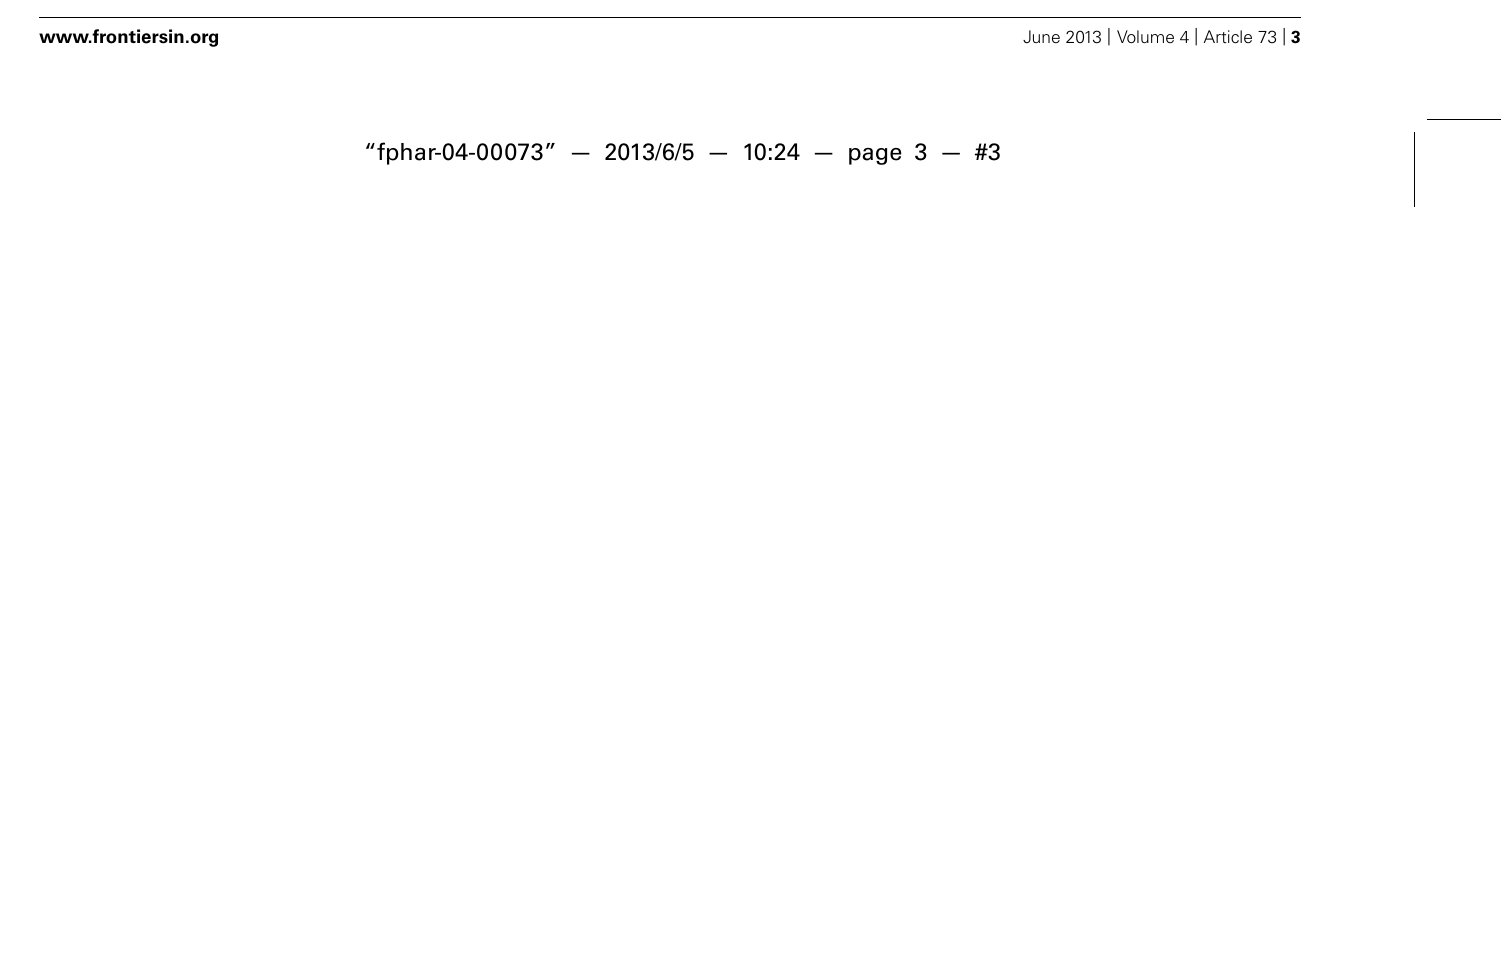
Cx43 fl/fl control mice, which were set to 100%, and 4-OHT-treated Cx43 Cre-ER(T)/fl mice. * p < 0.05. (C) Bar graphs represent the maximal slope of the PBFI fluorescence at 340 nm excitation and 500 nm emission of 4-OHT-treated Cx43 fl/fl and Cx43 Cre-ER(T)/fl mitochondria. * p <